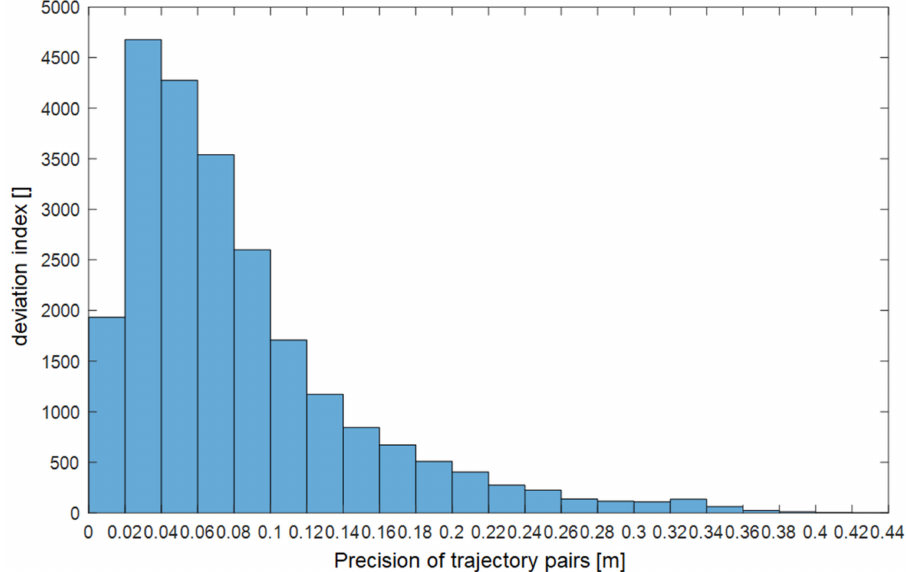
Figure 13. The histogram shows the statistical relationship between the precision of the nine drives taken from run 4 in the route